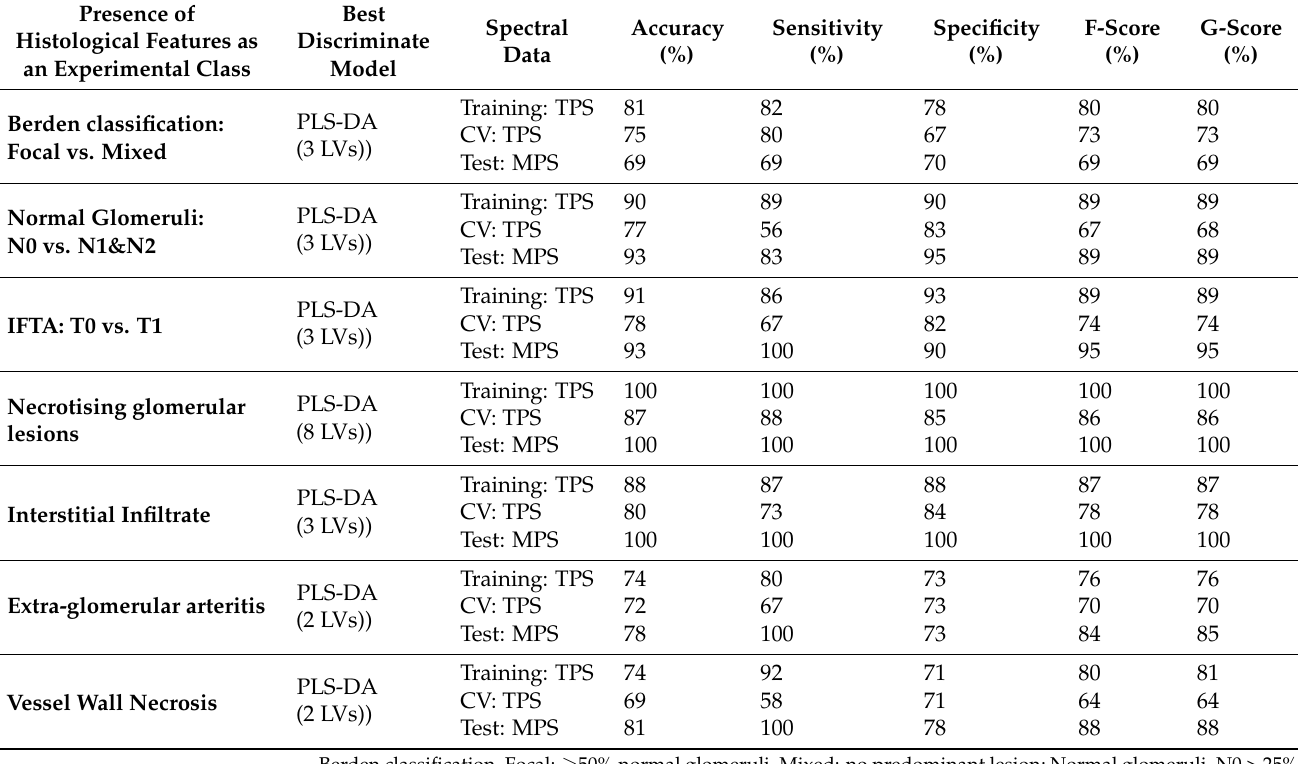
Table 2. Classification model performance according to histological data for renal biopsy samples (n = 27).